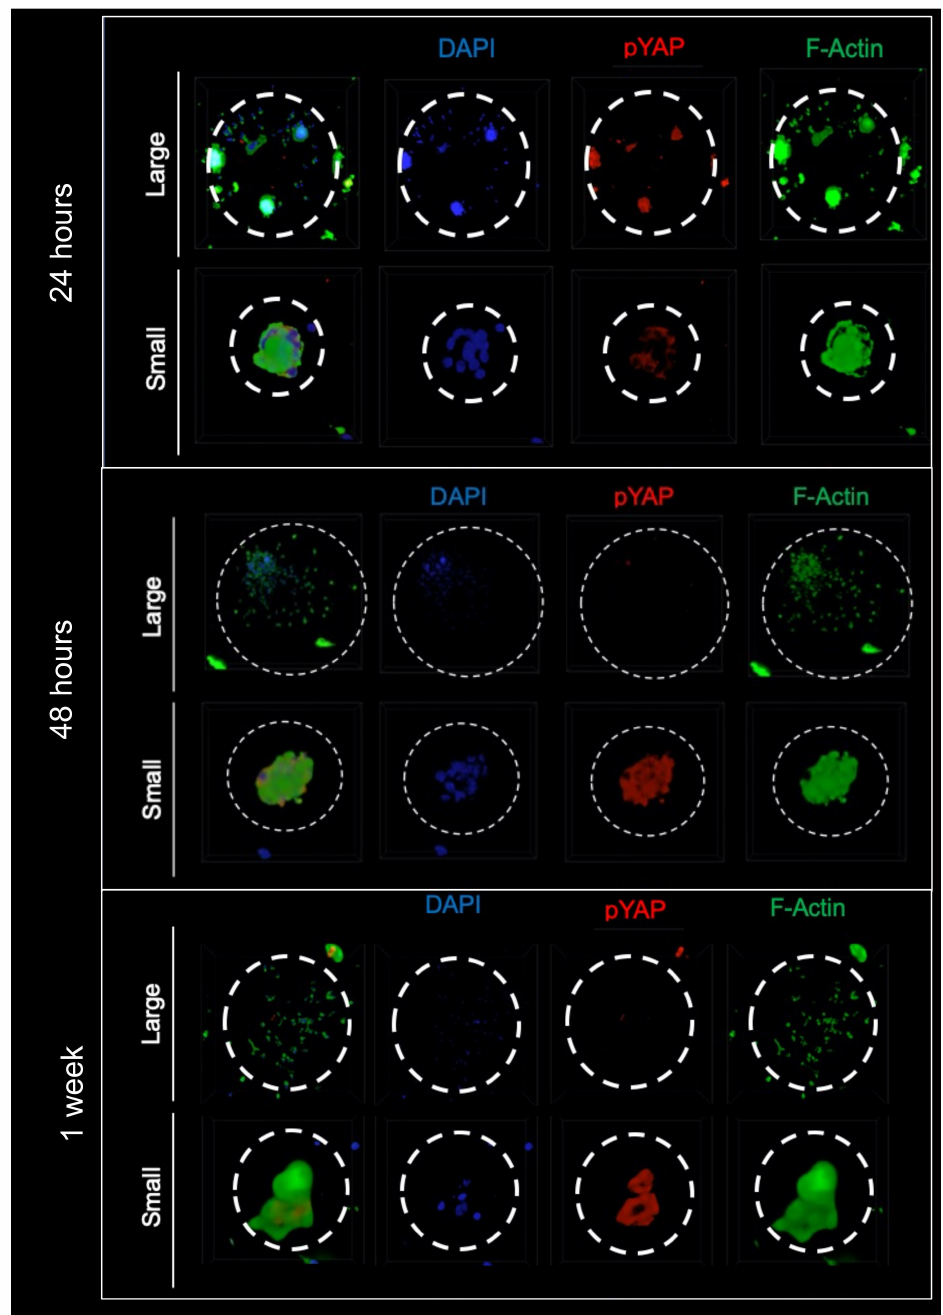
Figure 8. Bone marrow mesenchymal stem cells (BMSCs) are cultured on PDMS macropore-mimetic hemispheres for up to 1 week in vitro; changes in YAP phosphorylation (red) are observed by confocal laser microscopy and immunofluorescence. Hemisphere perimeters are outlined in white. Circular dotted lines indicate macropore